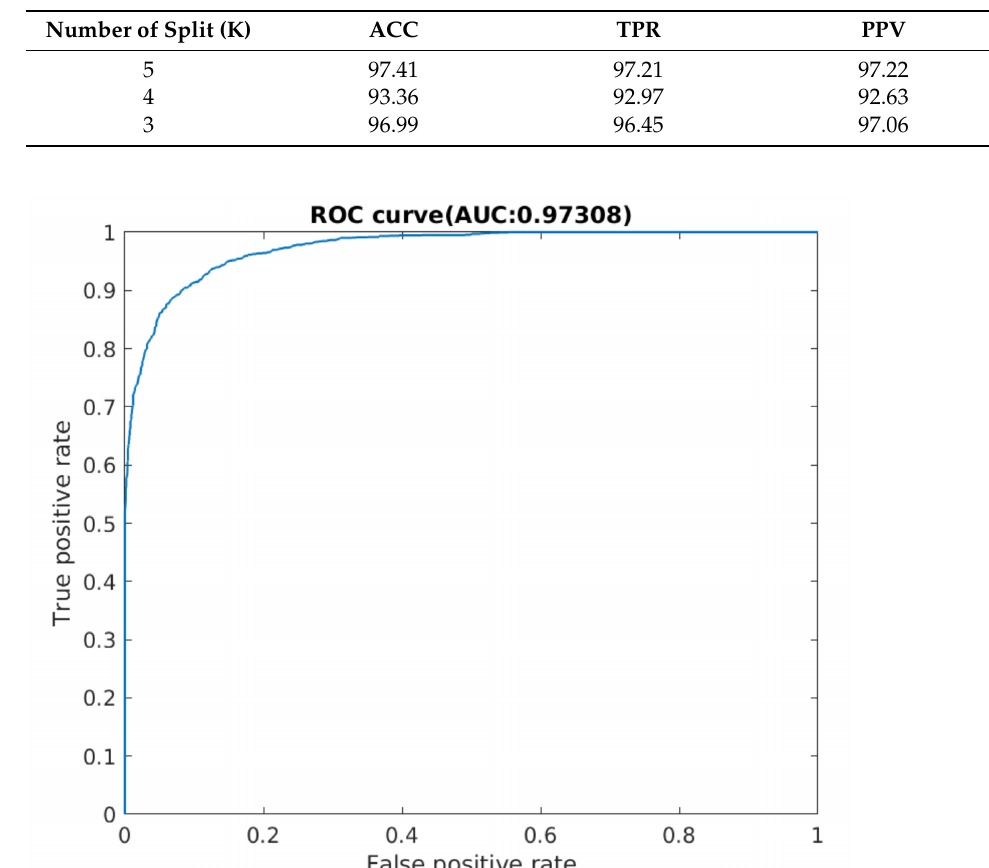
Table 7. The gender estimation model performance for the Adience dataset based on different cross-validation splits.